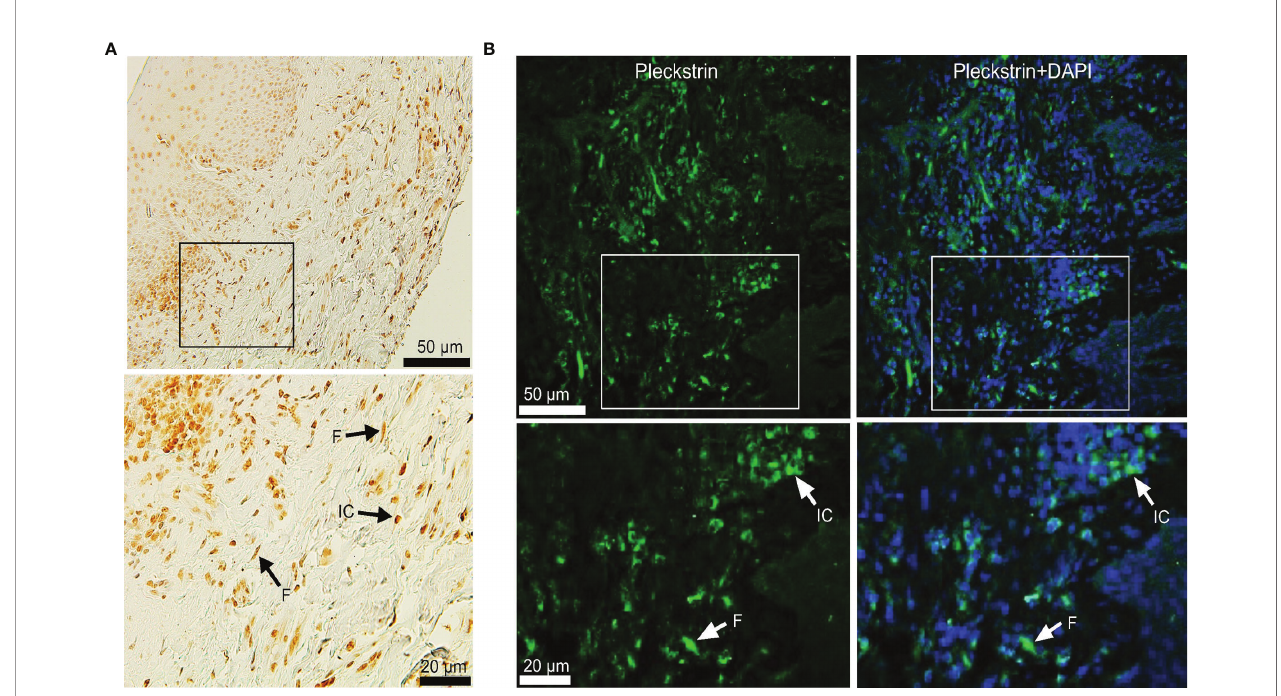
FIGURE 2 | Immunohistochemical staining of Pleckstrin expression in gingival tissue biopsies. (A) Representative histological staining of gingival tissue of patients with CP stained with DAB showing the detection of pleckstrin in gingival in fl ammatory cells and fi broblasts (black arrows in the highlighted area). (B) Immuno fl uorescence staining of pleckstrin in human gingival biopsy. The confocal images show the localization of pleckstrin (green) with a DAPI (blue) staining. DAPI was used as a nuclear staining of tissue cells. The square areas were highlighted below the images with in fl ammatory cells (IC) and fi broblasts (F) for pleckstrin positive staining (white arrows). Scale bars: 20 m m and 50 m m. CP, Chronic